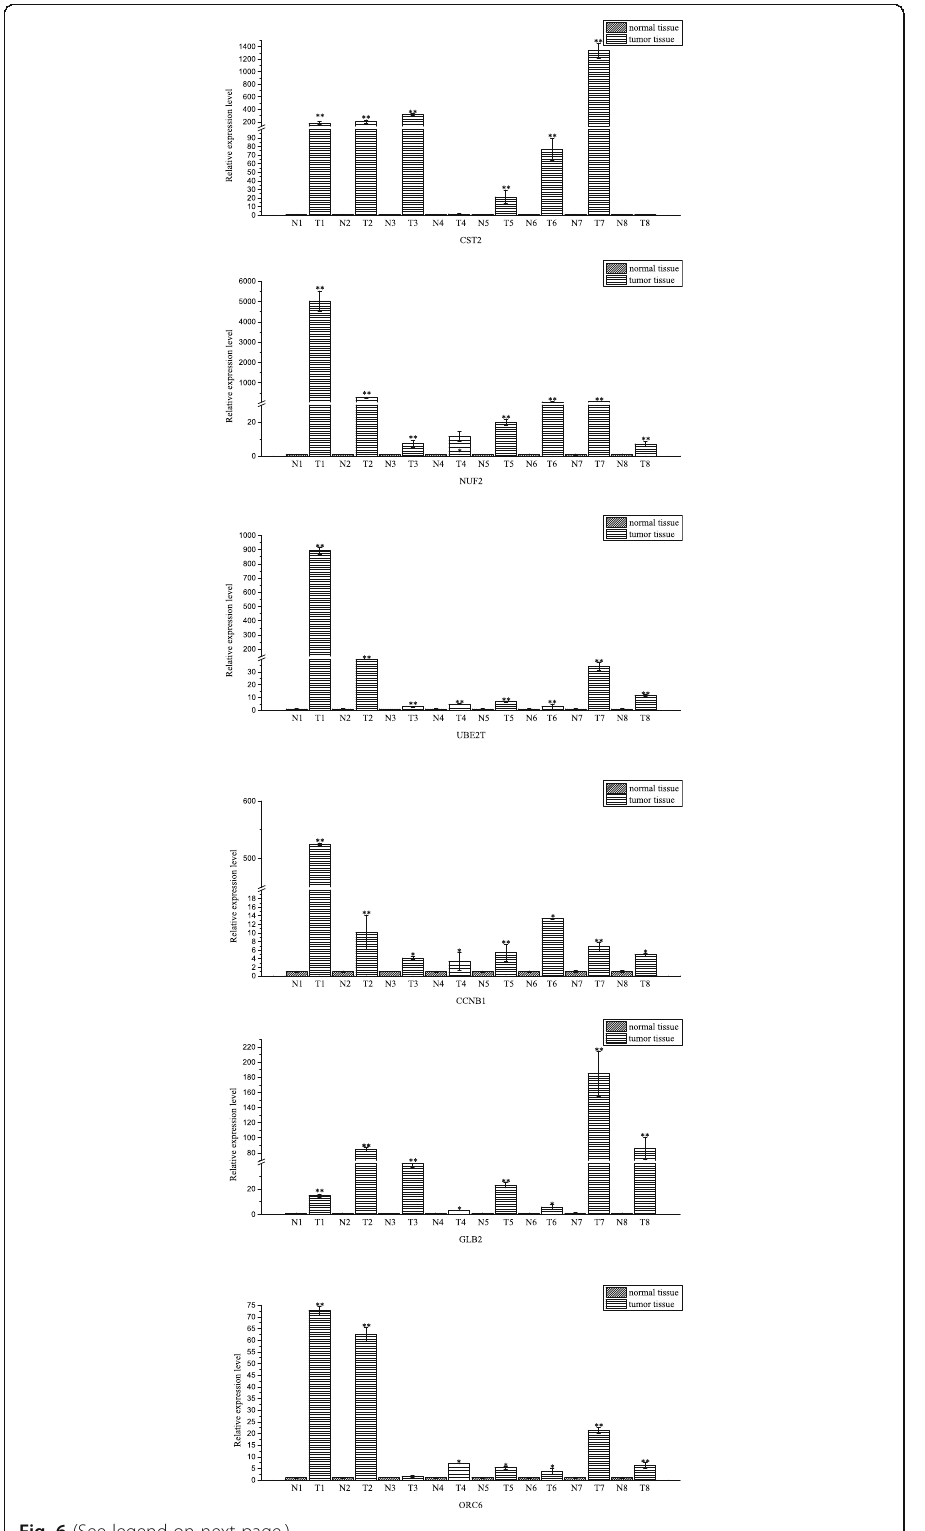
Fig. 6 (See legend on next